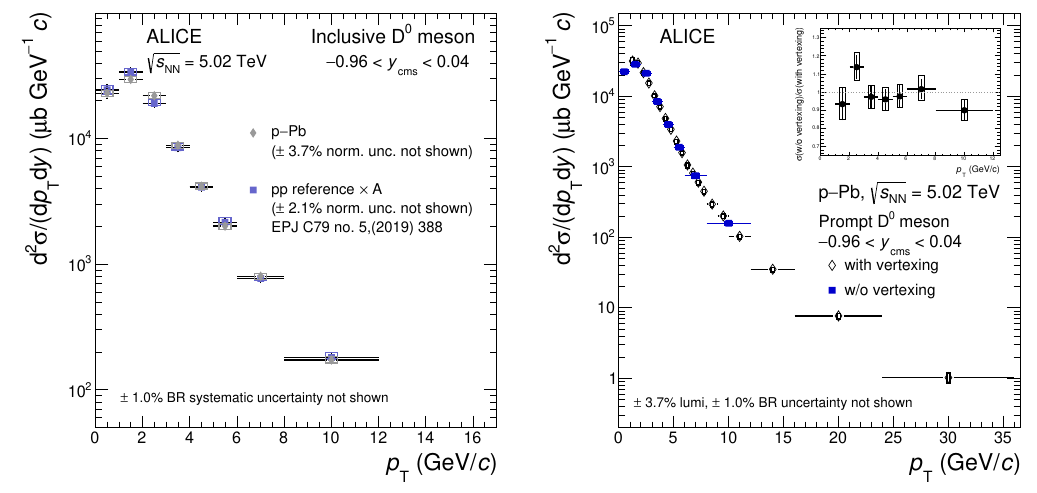
Figure 6 . Left: inclusive D 0 -meson production cross sections from the analysis without decay- vertex reconstruction in p{Pb collisions and pp collisions, both at section measured in pp collision [70] is scaled by the Pb mass number ( A = 208) and corrected for the rapidity shift in p{Pb collisions using FONLL calculations. Right: p T -di(cid:11)erential production cross section of prompt D 0 mesons with (cid:0) 0 : 96 < y cms < 0 : 04 in p{Pb collisions at measured with and without decay-vertex reconstruction. The vertical bars and the empty boxes represent the statistical and systematic uncertainties. The inset shows the ratio of the measurements in their common p T